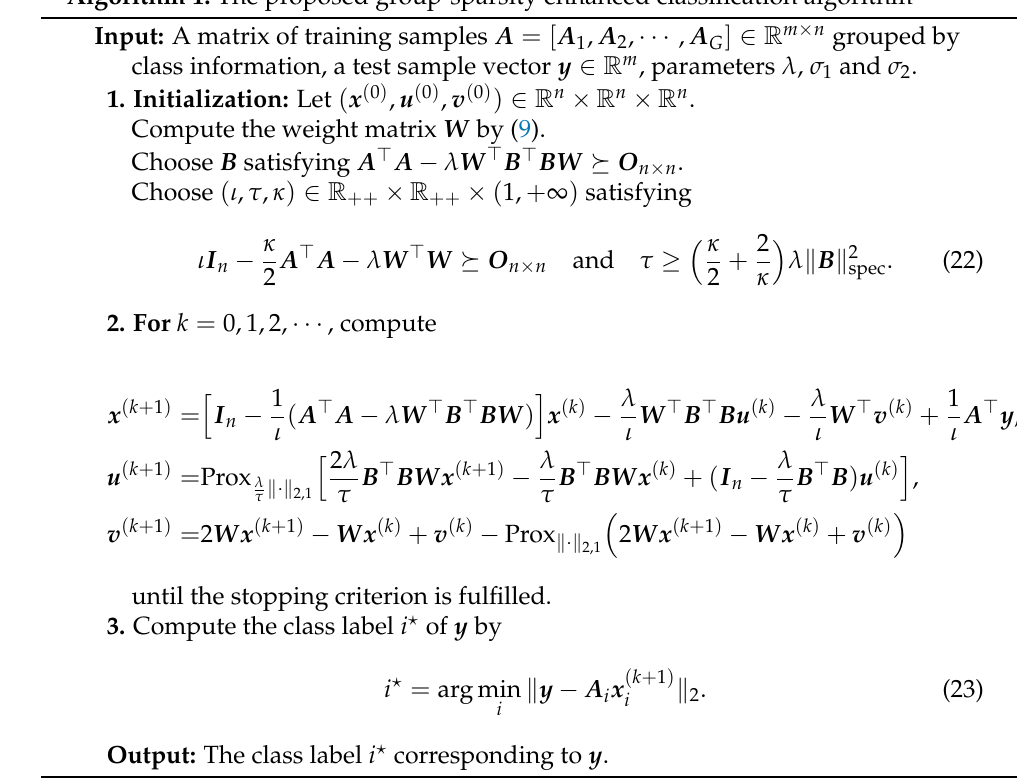
Algorithm 1: The proposed group-sparsity enhanced classification algorithm